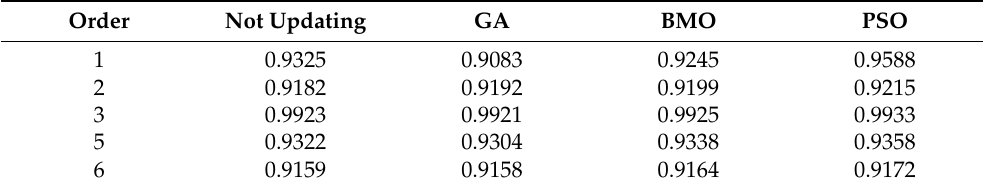
Table 6. The MAC comparison results of the cable-stayed bridge.